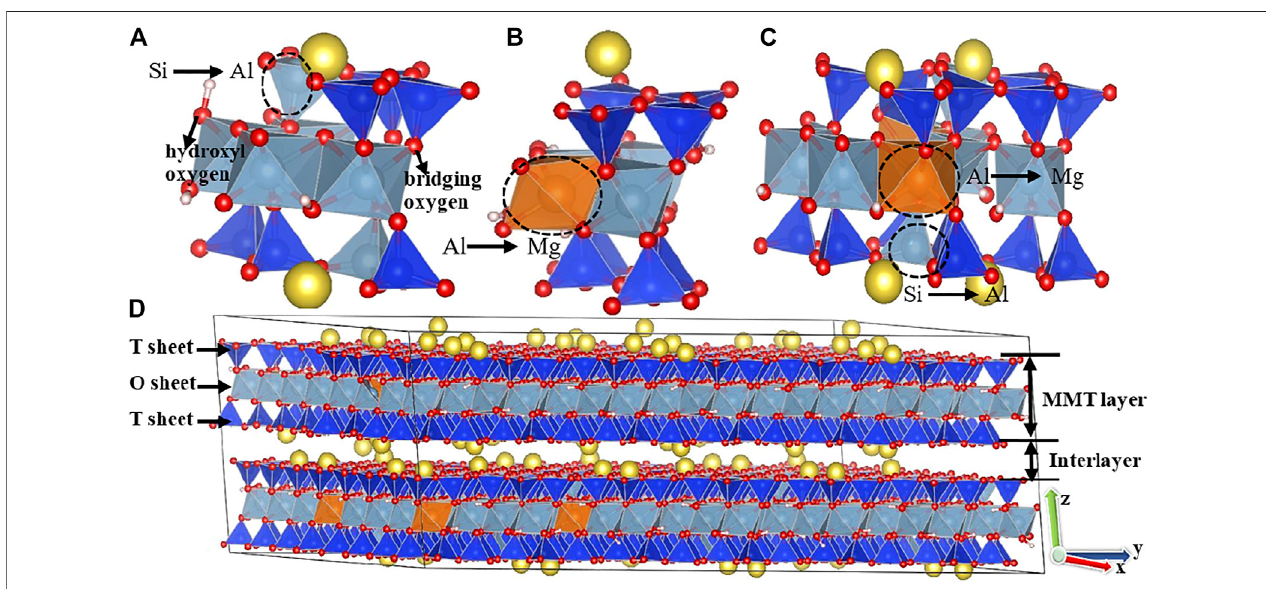
FIGURE1| Schematicviewsof (A) thetwounitcellsfortheM1Model, (B) theunitcellfortheM2Model,and (C) thefourunitcellsfortheM3Modelandsnapshotof (D) the molecular dynamic simulation supercell for the M3 Model with the layer charge of 0.75 e/uc. The color code is Si (blue), Al (blue-grey), Mg (orange), O (red), H (pink), and Na (yellow). The atoms in the black circle are the representative atoms of